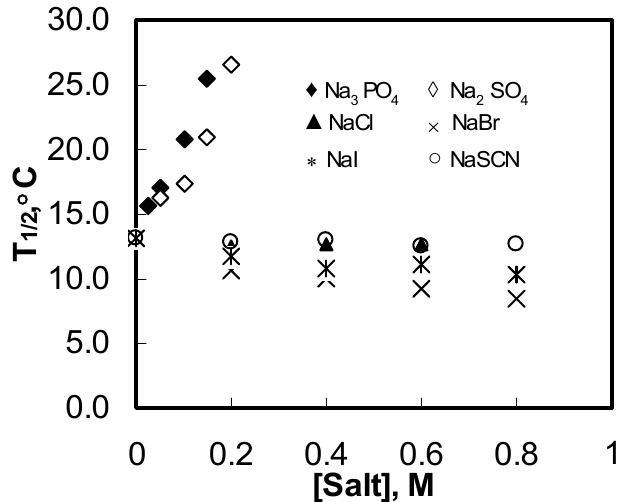
Figure 4. T variations for aqueous solutions of 1 wt% HPMC as a function of the added 2/1 salts concentration during the heating process.